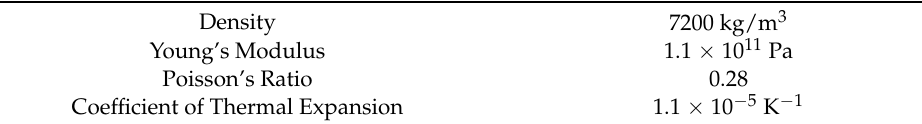
Figure 2. Ventilated brake disc model.